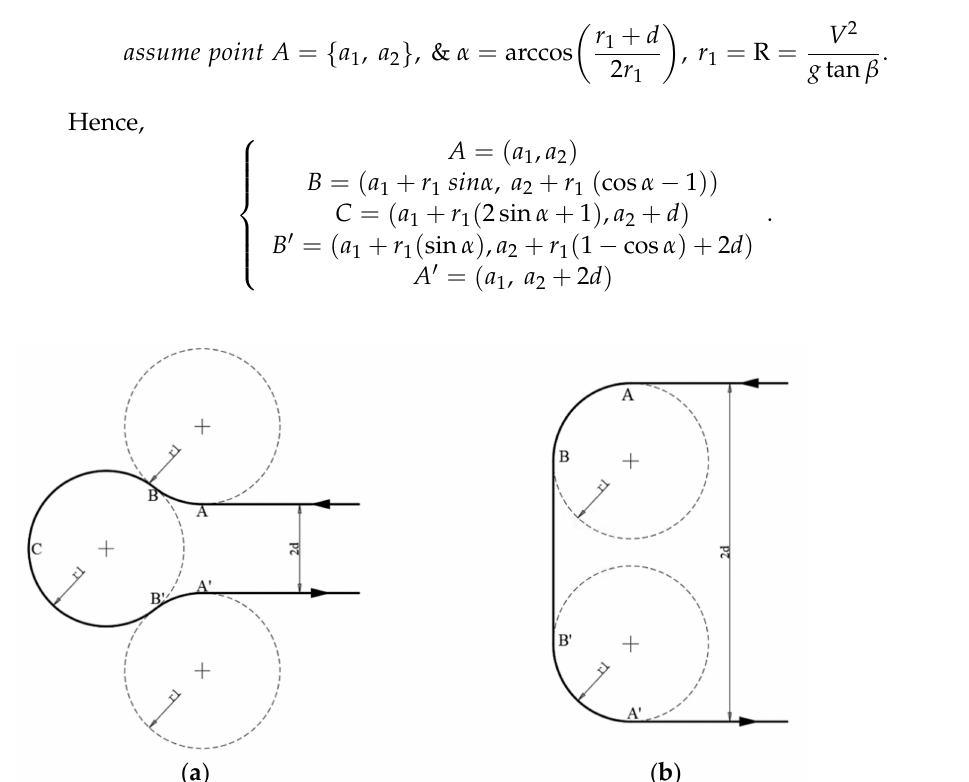
Figure 6. ( a ) illustrates the Dubins path (an RLR instance) when d < R , whereas ( b ) shows the Dubins path (an LSL instance) when d ≥ R .